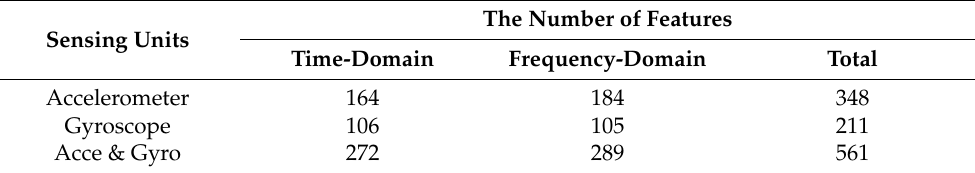
Table 1. The UCI-HAR dataset